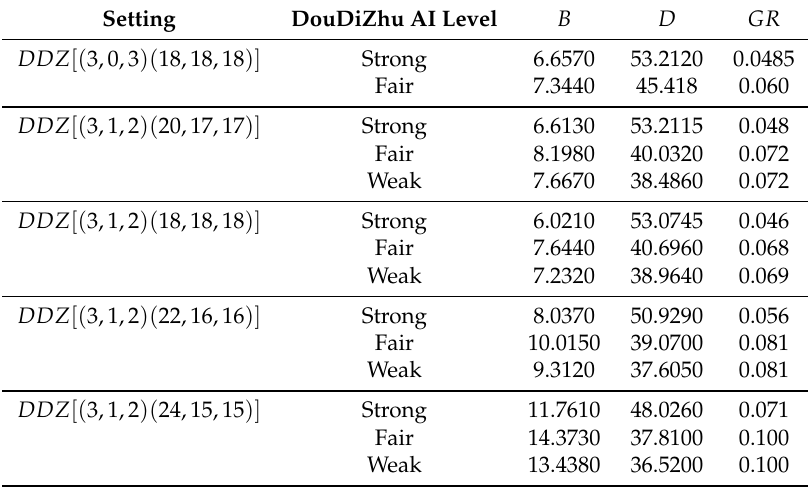
Table 5. The results of simulation performed using different DouDiZhu artificial intelligences (AIs) for various game settings. Setting